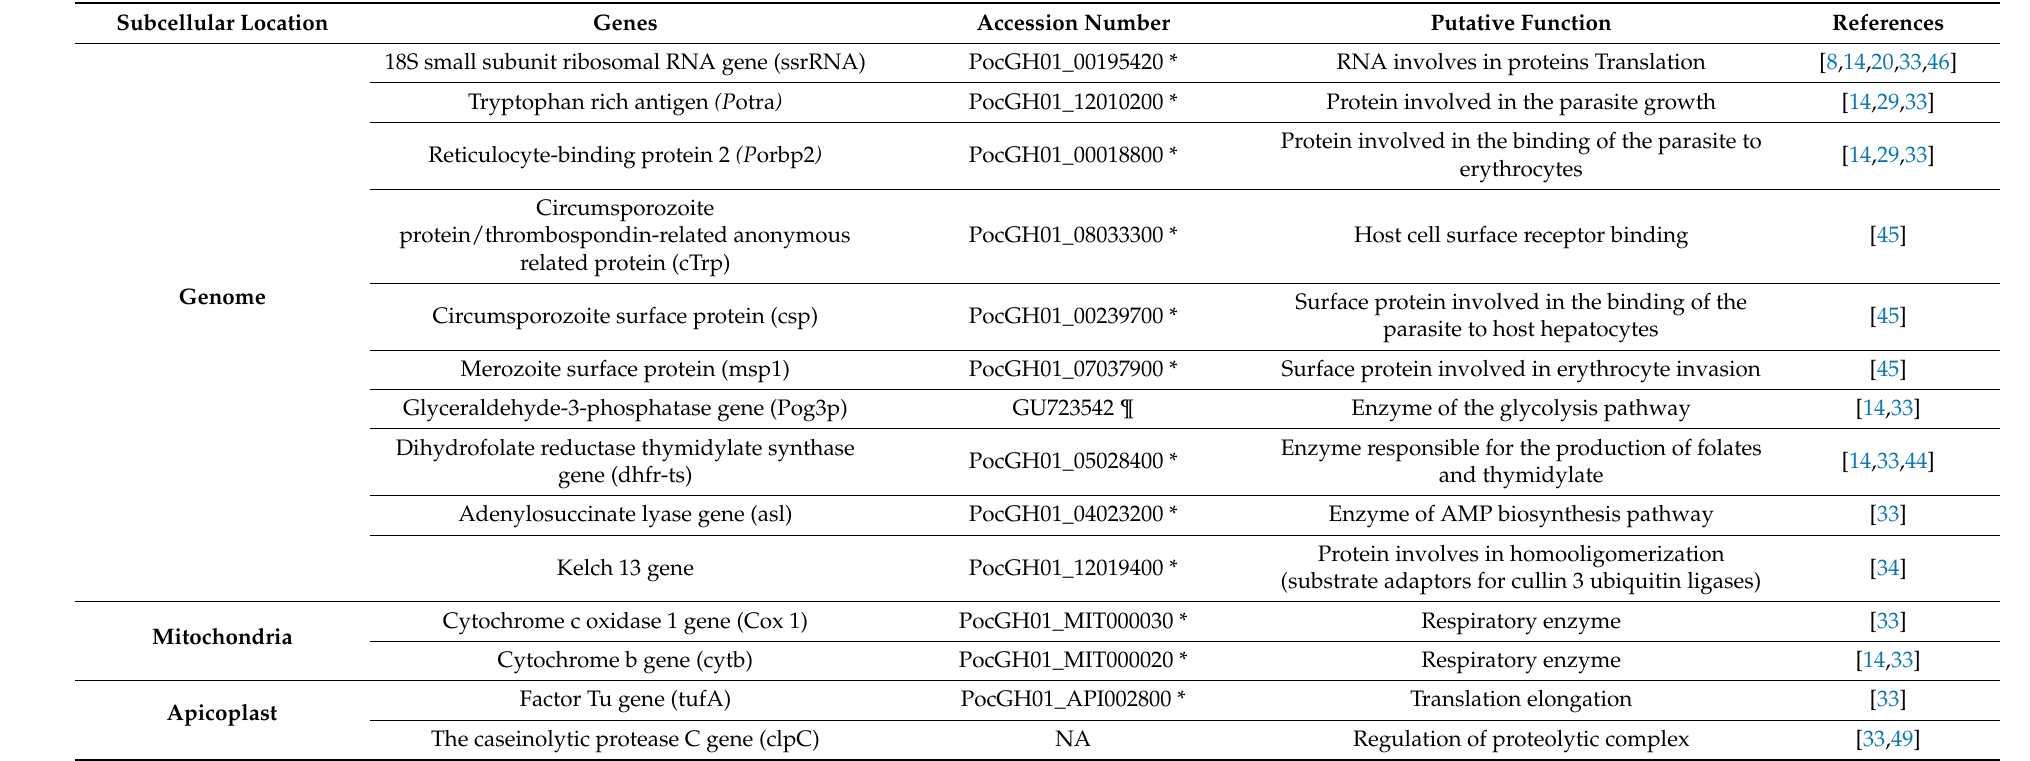
Table 1. Some current genes used for molecular identification of P. ovale